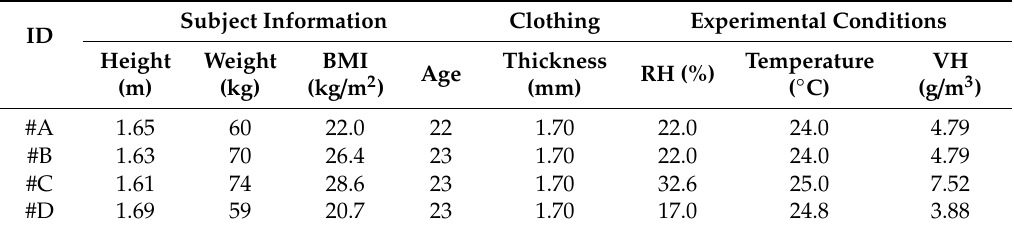
Table 2. Subject information and experimental conditions in cECG measurement.